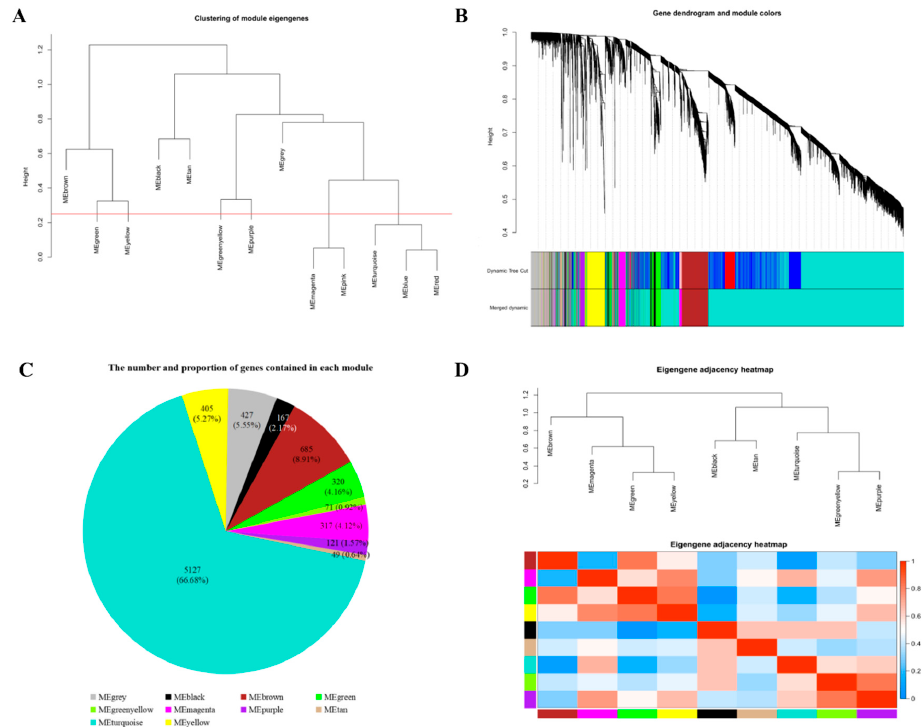
Figure 3. Identification of coexpression modules by weighted gene coexpression network analysis. ( A ) The cluster dendrogram of gene modules eigengenes. Modules with similar expression patterns need to be merged and the red line is the merging threshold. ( B ) The gene clustering dendrogram was obtained according to hierarchic clustering of adjacency-based dissimilarity. The color blocks below the tree graph represent coexpression modules recognized by the dynamic hybrid-cutting method. The genes in grey module were not classified into any coexpression modules. ( C ) The number and proportion of genes contained in each module. ( D ) The adjacency heatmap of eigengene. Above is the module clustering tree, and below is the corresponding module clustering heatmap. Red represents strong correlation and blue represents weak correlation.